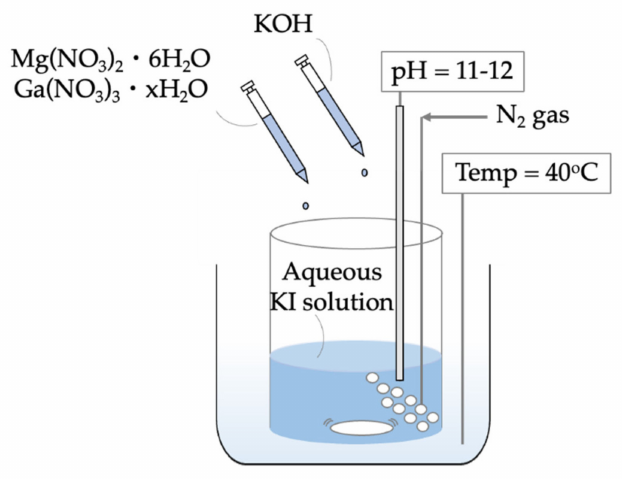
Scheme 1. Experimental setup for the synthesis of MgGa–LDHs intercalated with